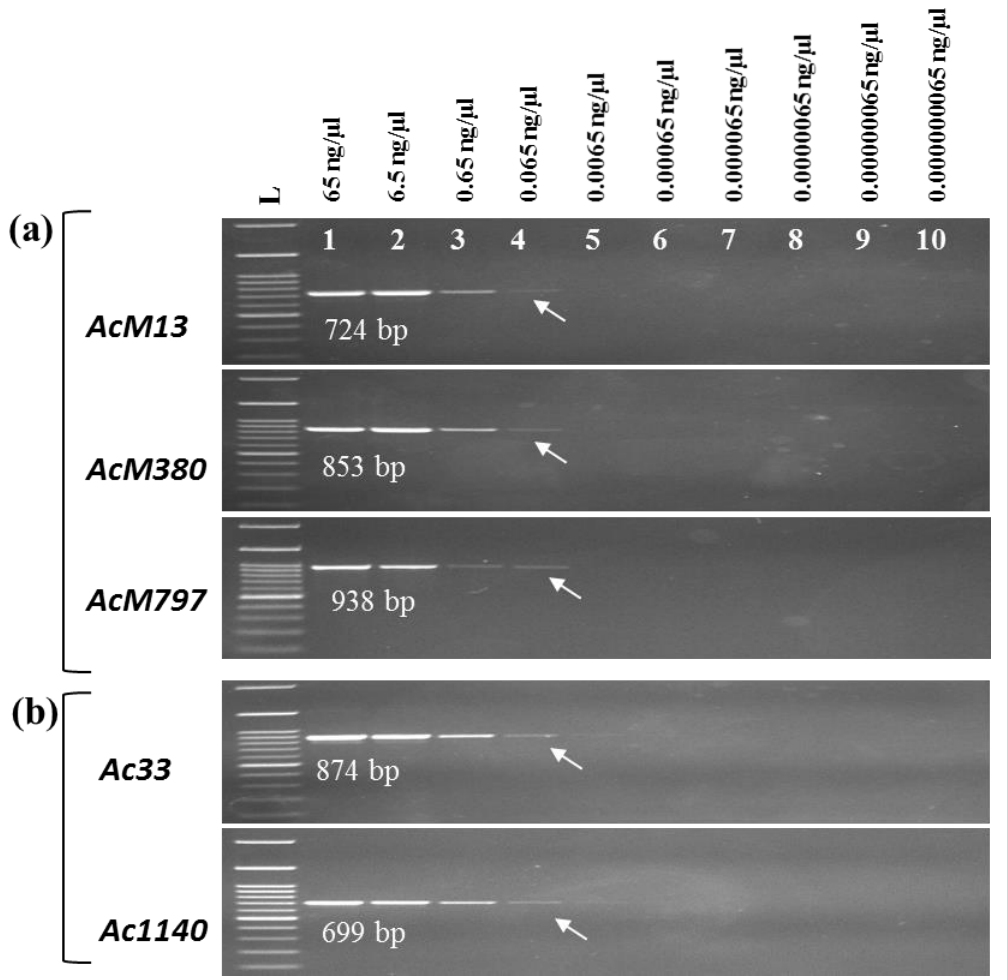
Figure 5. DNA detection limits of the PCR assays. Detection limit of gDNA of A. citrulli strain using “ Ac M” strain-specific primer sets ( a ) AcM13 , AcM380 , and AcM797 and ( b ) A. citrulli strain-specific primer sets Ac33 and Ac1410 in PCR assays. Lanes 1 to 10, 10-fold dilution series of gDNA of A. citrulli strain NIHHS15-280 starting from 65 ng/µL; Lane L contains HIQ 100 bp plus DNA Ladder Mix (BIONEER, Republic of Korea) as a size marker.